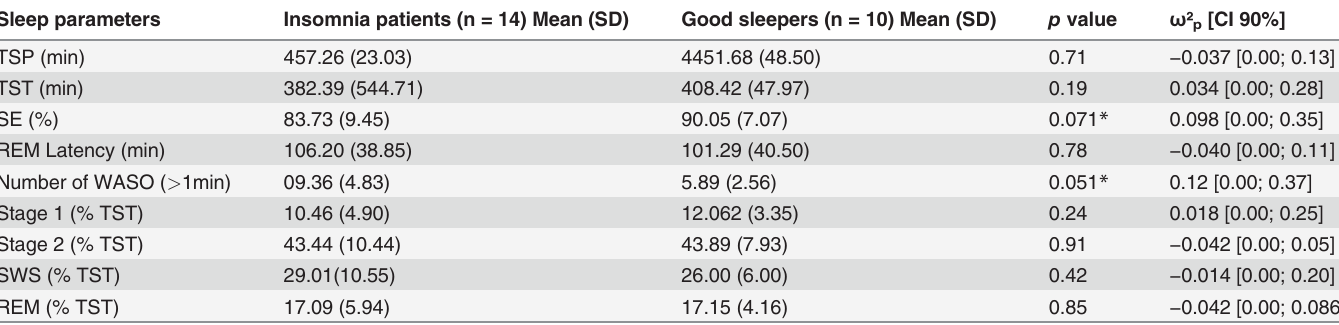
Table 2. Sleep characteristics of participants.